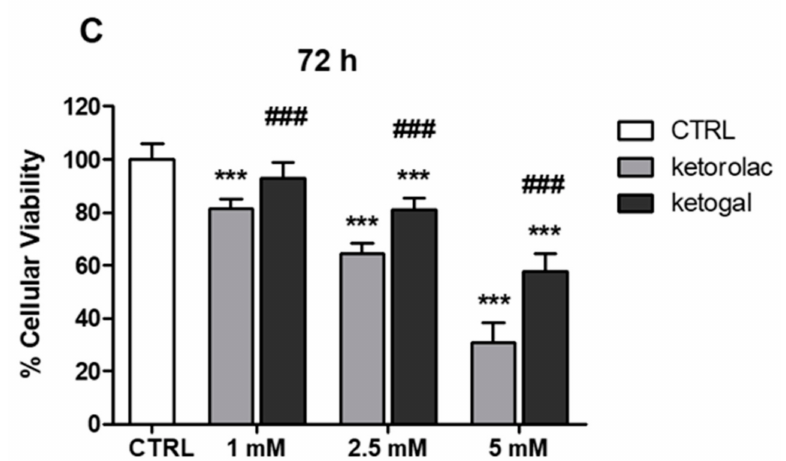
Figure 2. Effect of ketorolac and ketogal on the mitochondrial activity of human CoEpi cells. Cells were incubated for 24 ( A ), 48 ( B ), and 72 ( C ) h either in the absence (CTRL) or presence of 1, 2.5, or 5 mM ketorolac or ketogal. Data are presented as means ± SEM ( n = 3). Significance of treated (ketorolac or ketogal) versus respective untreated cells: *** p < 0.001. Significance of ketogal vs. ketorolac: ### p <